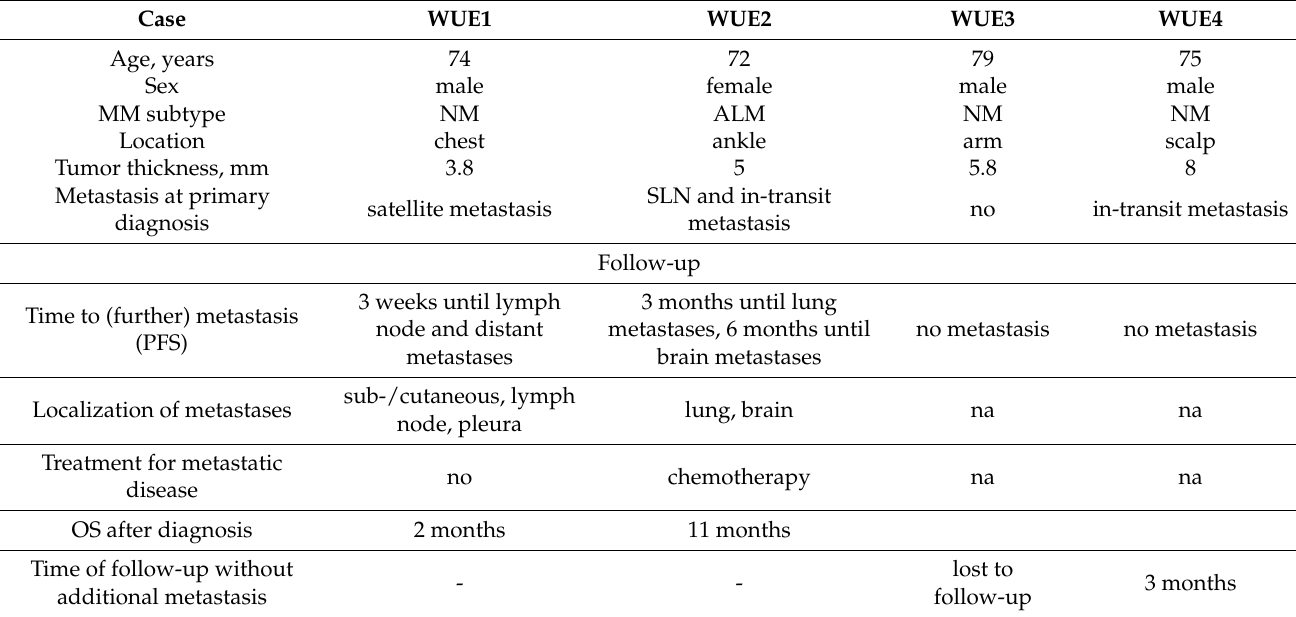
Table 1. Clinical characteristics of primary rhabdoid